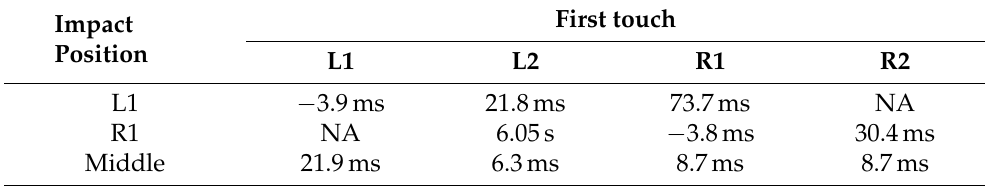
Figure 16. Matrix sensor tests with different impact points by changing sensor position. Table 4. First touch identification for matrix sensor using